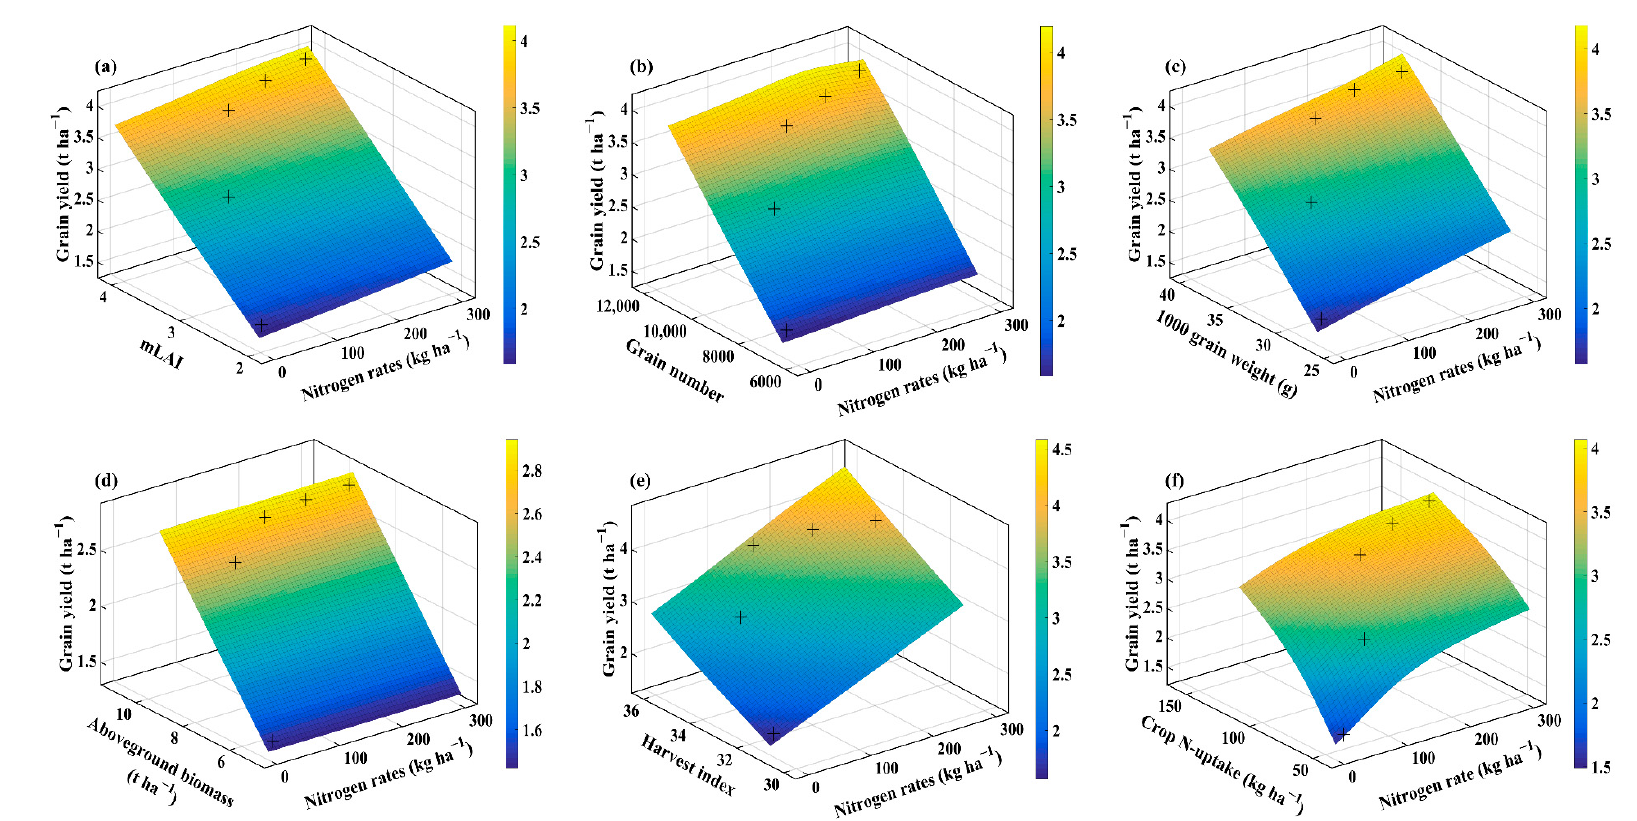
Figure 4. Thin plate smoothing spline plots showing the interaction of N rates ( x -axis) with mLAI, grain number, 1000 grain weight, aboveground biomass, harvest index, and crop N-uptake ( y -axis) on average grain yield ( z -axis) in 2013–2014 growing season. The various panels show mLAI ( a ); grain number ( b ); 1000 grain weight ( c ); aboveground biomass ( d ); harvest index ( e ); and crop N-uptake ( f ) for the 2013–2014 growing season, respectively. + indicates the observed data.